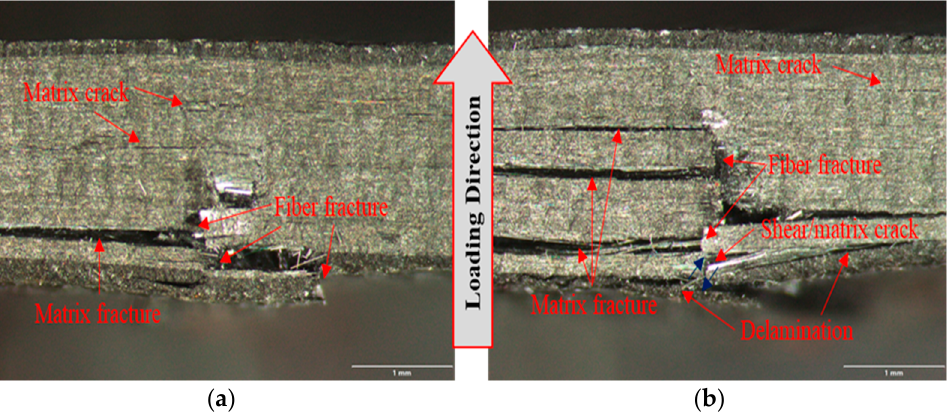
Figure 23. Optical microscopic images of bending specimen in the gage section near the loading